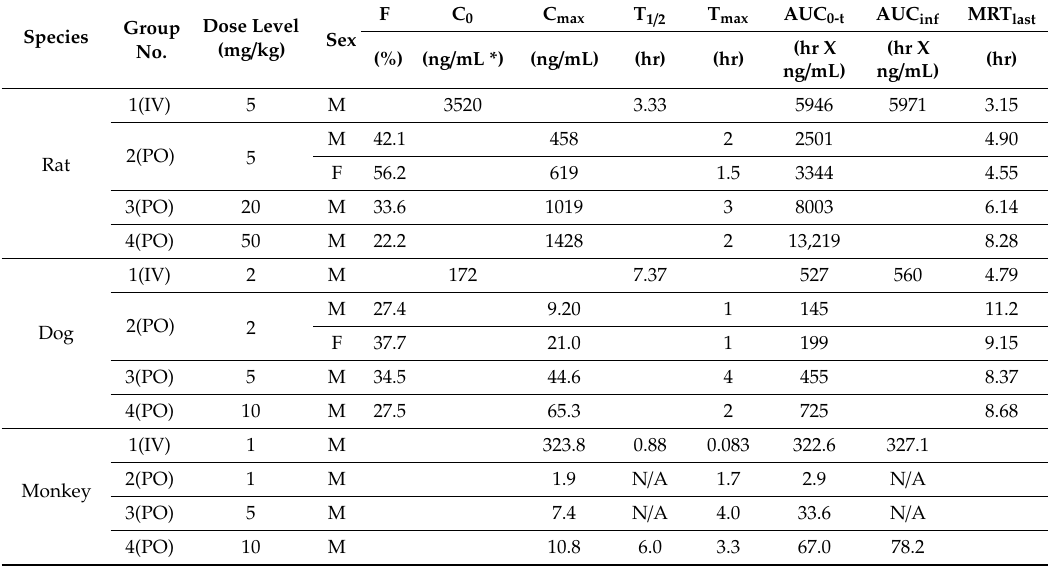
Figure 4. Pharmacokinetics of ABN401. Plasma concentration–time profiles of ABN401 following intravenous and oral administration in ( A ) SD rats, ( B ) beagle dogs, and ( C ) cynomolgus monkeys. The pharmacokinetic profiles including F% (bioavailability), C 0 , C max , T max , T 1 / 2 , AUC 0-t , and AUC inf were measured after intravenous (IV) administration at 5 mg / kg and oral (P.O) administration at 5, 20, or 50 mg / kg in SD rats and IV at 2 mg / kg and oral administration at 2, 5, and 10 mg / kg in beagle dogs. In the cynomolgus monkeys, systemic exposure to ABN401 was detected after a single oral administration at 1, 5, and 10 mg / kg and after a single IV dose of 1 mg / kg. Table 3. Pharmacokinetics of ABN401 following Intravenous / Oral Administration in (A) SD rats, (B) beagle dogs, and (C) cynomolgus monkey.